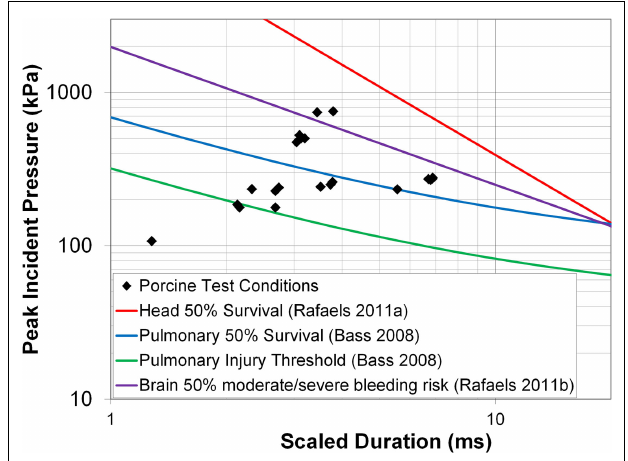
FIGURE 4 | Porcine test conditions plotted against blast injury and fatality risk curves for the pulmonary system (Bass et al., 2008) and the head/brain (Rafaels, 2011).